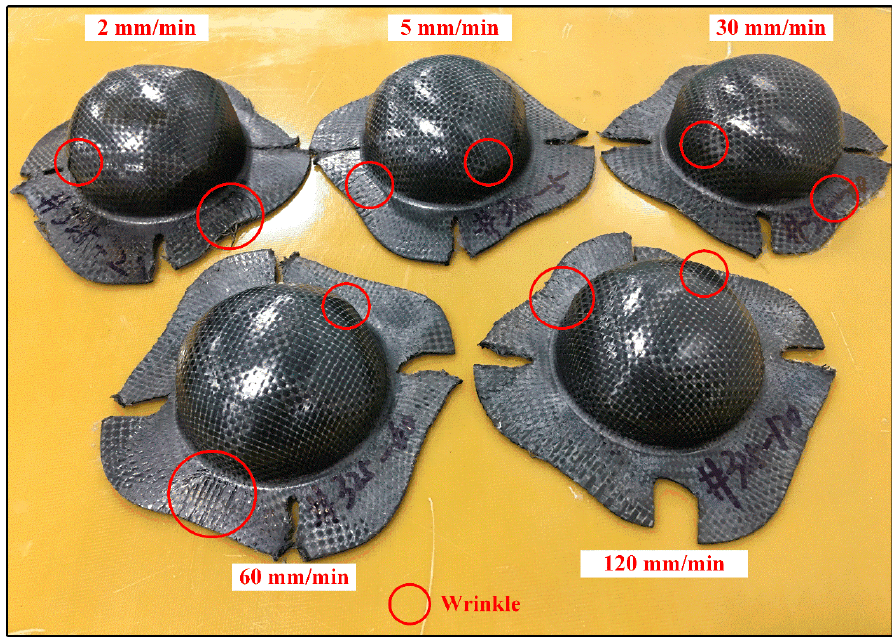
Figure 13. The fracture specimens of the Erichsen test of woven CF/PEEK sheets at different speeds (325 °C).